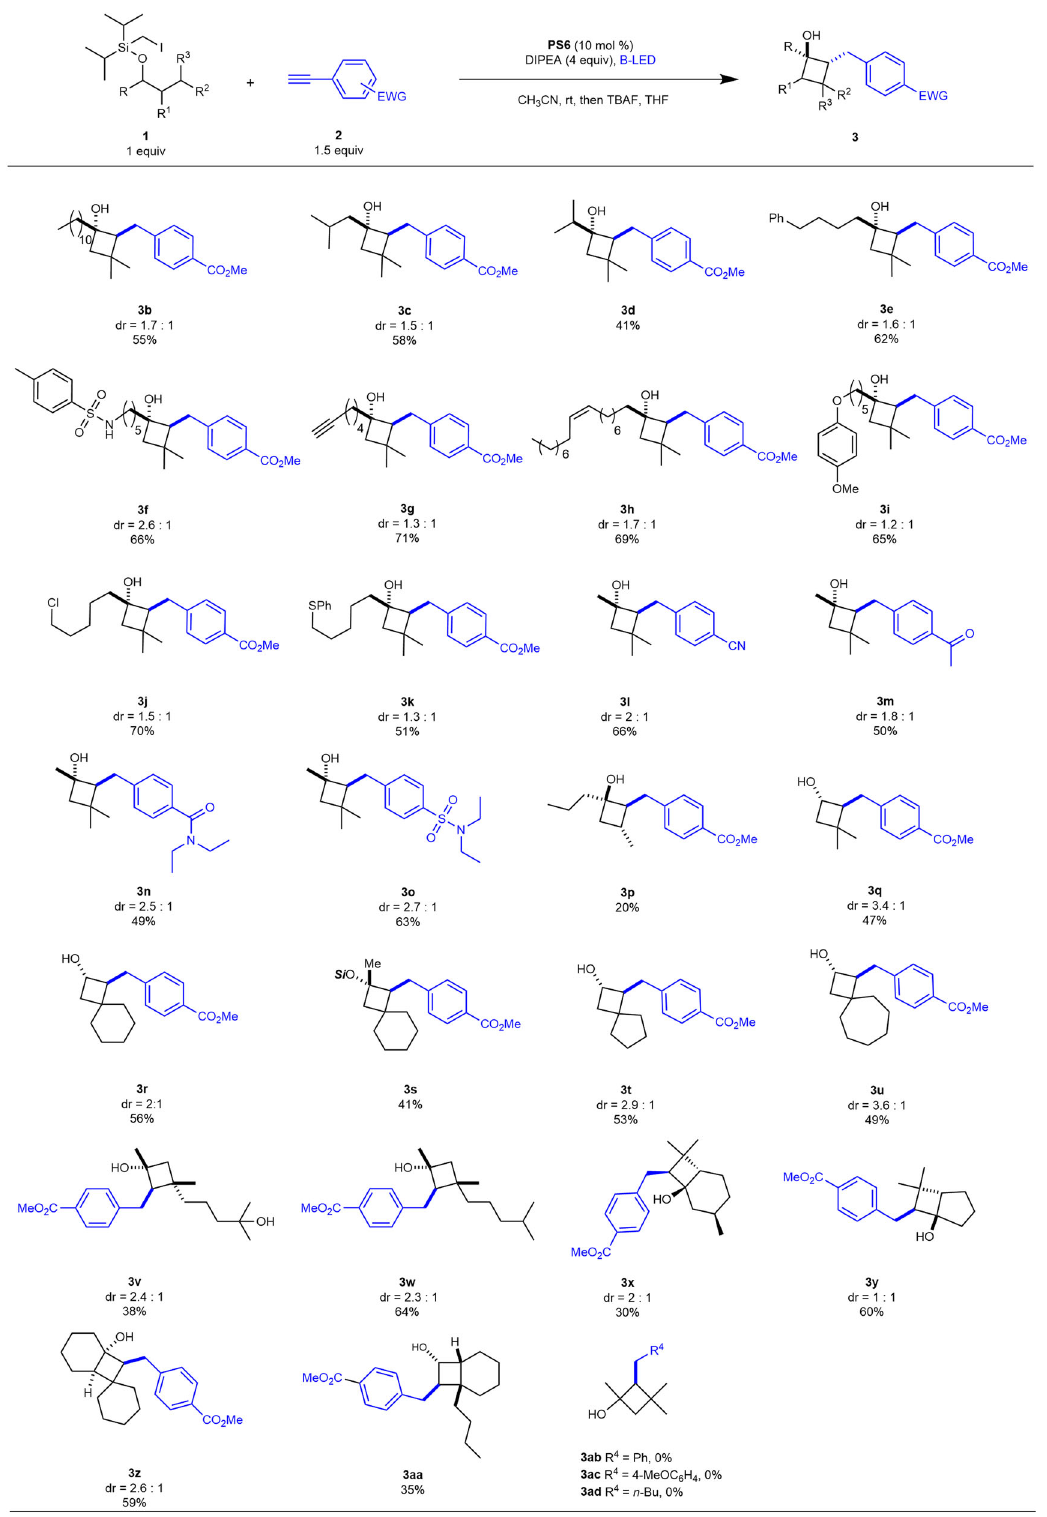
Fig. 3 Scope of substrates considered in the study. Reaction conditions: 1 (0.1 mmol), 2 (0.15 mmol), PS6 (10 mol %), DIPEA (4 equiv) in MeCN, under N 2 , rt, B-LED, 24 h. The relative con fi gurations were assigned by NOE analysis; no deprotection for 3 s